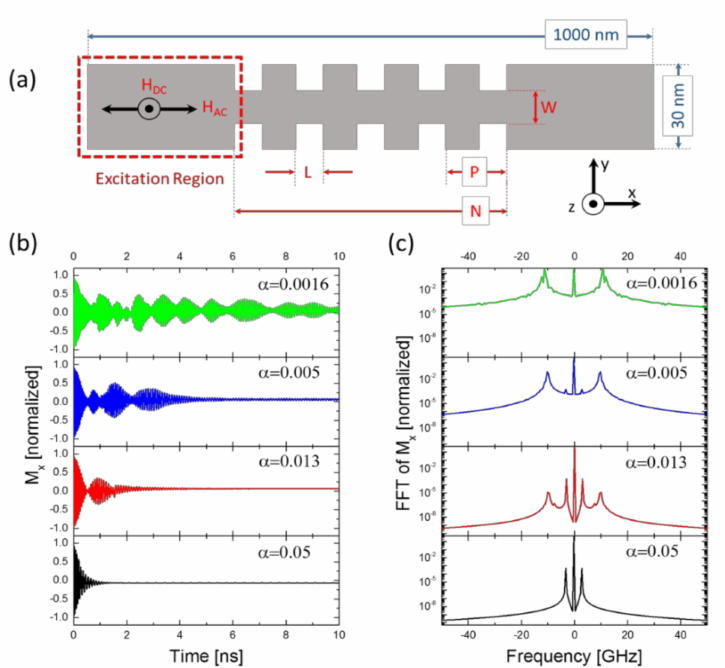
Figure 1. Filter geometry applied external RF and DC magnetic field regions and transmission along with x-axis magnetization. ( a ) The simulated nanowire geometry with the orientations of external RF and DC magnetic field (respectively, H AC and H DC ) excitations (dimensions not to scale). The effect of increasing Gilbert damping coefficient on transient M x in ( b ) time and ( c ) frequency (for 8–10 ns time window) domains (the rest of the parameters were held